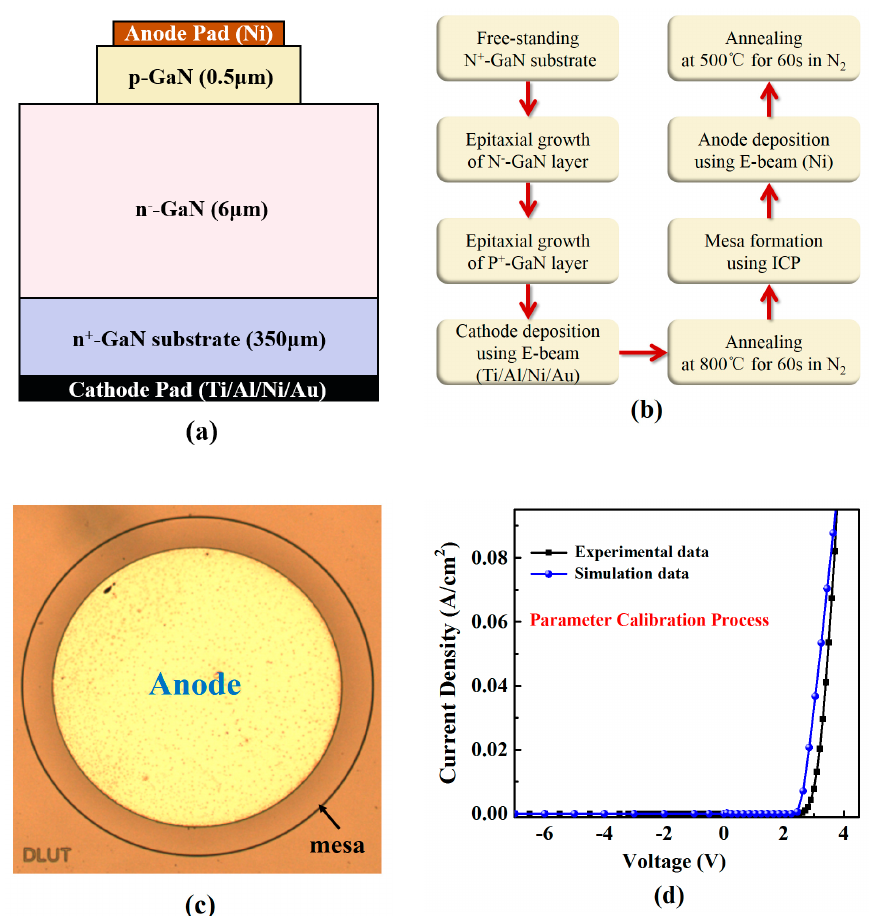
Figure 2. ( a ) Schematic cross-section, ( b ) fabrication process flow, ( c ) top view of the fabricated GaN pn-junction device, and ( d ) parameter calibration process by benchmarking the simulated I–V characteristics of GaN pn-junction device with the experimental data.